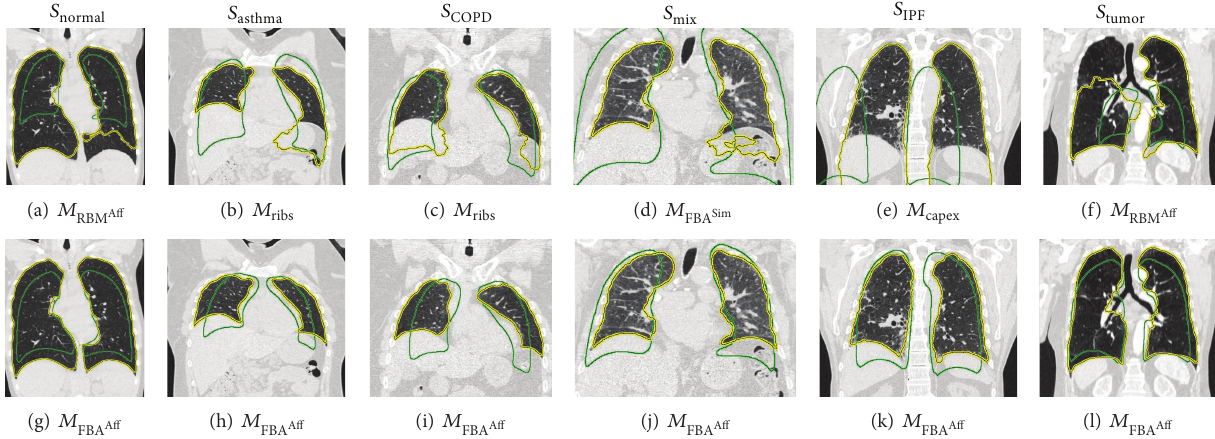
Figure 4: Two examples of model initializations based on different methods. The method 𝑀 shape whereas the other methods are off in at least one of the examples.